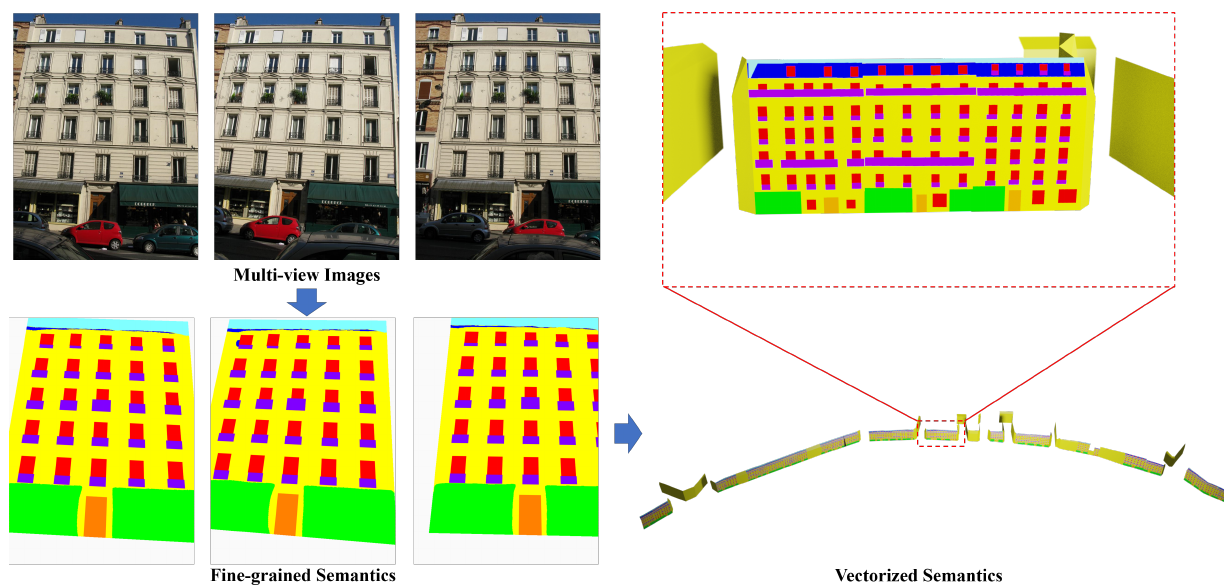
Figure 8. Visualization of our model reconstruction in Dataset [38]. The top of the figure is shows the multi-view images, and the middle of the the figure is the image segmentation produced by GCO optimization based on DeepLabv3+ [34] segmentation results, and the bottom is the vectorized semantics with pseudo building